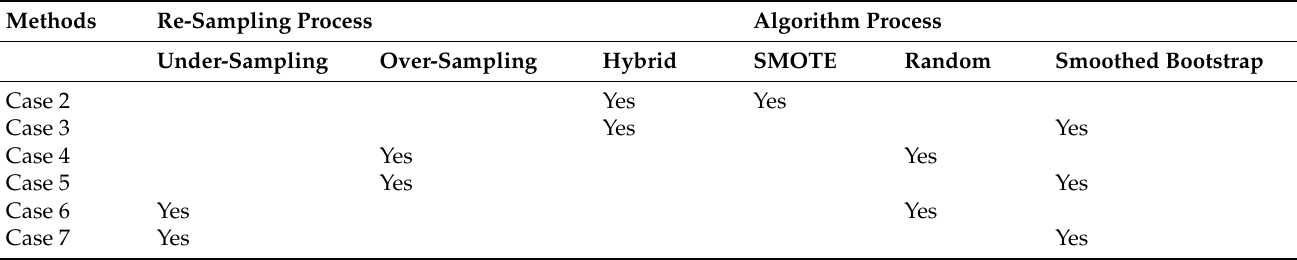
Table 6. Re-balanced